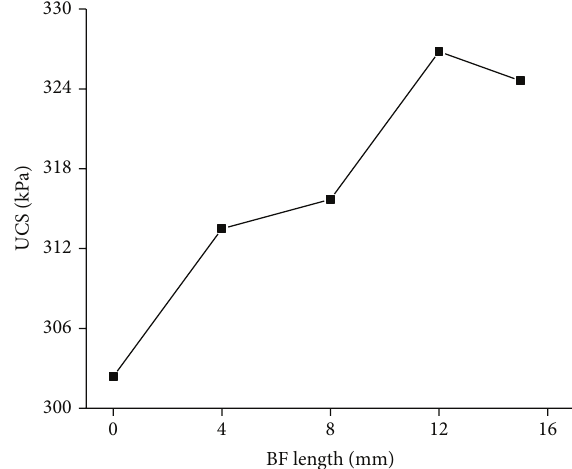
Figure 4: Effect of basalt fiber (BF) length on unconfined compres- sive strength (UCS) of soil